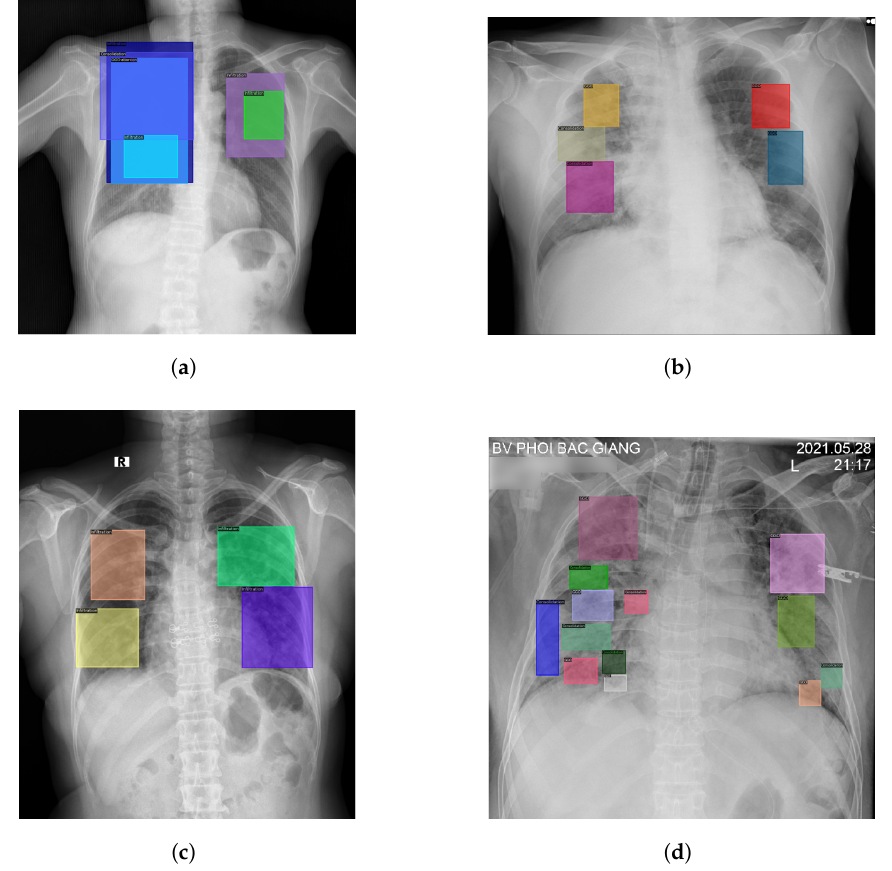
Figure 13. Difference of annotating styles between training and testing datasets. ( a ) VinBig (6 Infiltra- tion, 1 GGO, 1 Consolidation). ( b ) SIIM (3 GGO, 1 Consolidation). ( c ) VinTest (4 Infiltration). ( d ) BG COVID (7 GGO, 6